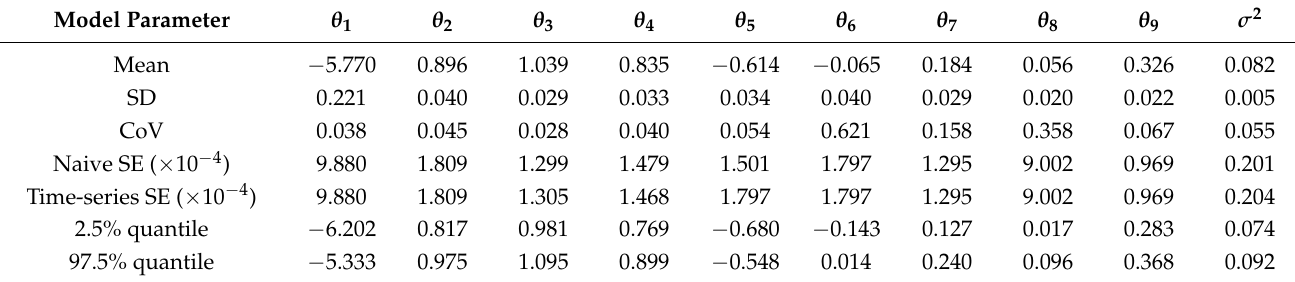
Table 3. Calculation results of probabilistic shear strength model